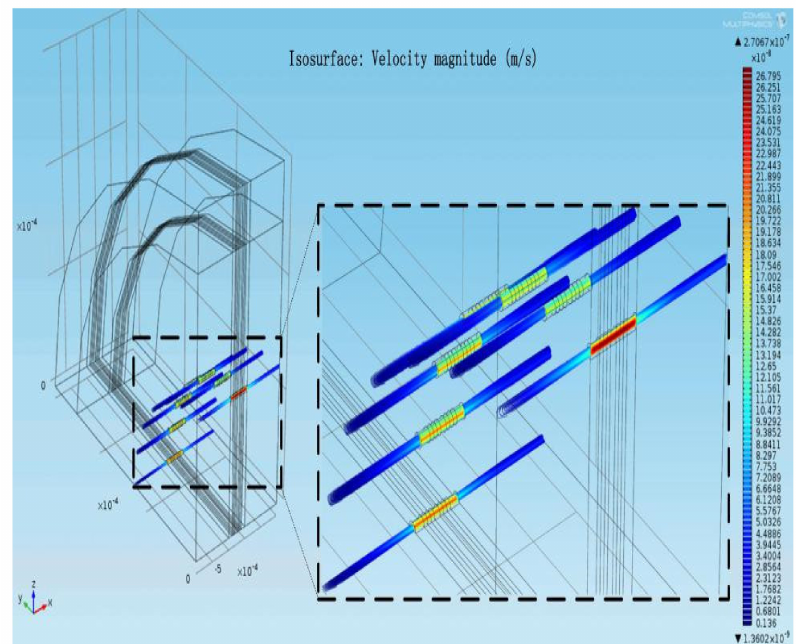
Figure 3. Electrolyte motion in reaction cavity at 5 s under b a = 0.01sin ( π t ) m/s 2